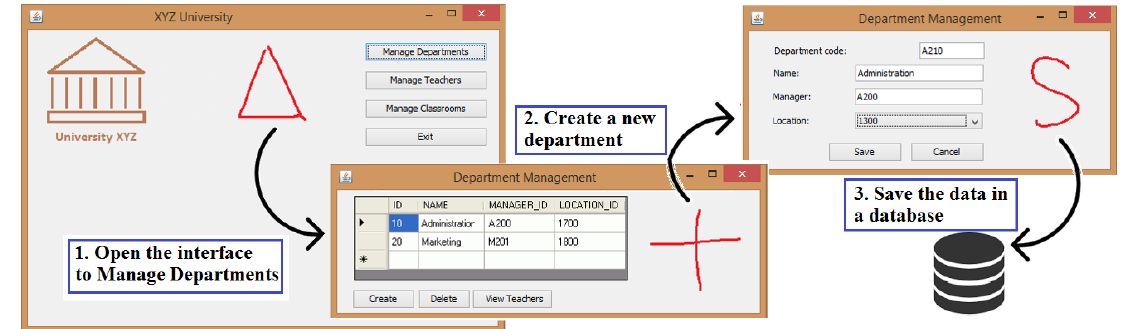
Figure 19 . Using gestures to execute actions on the